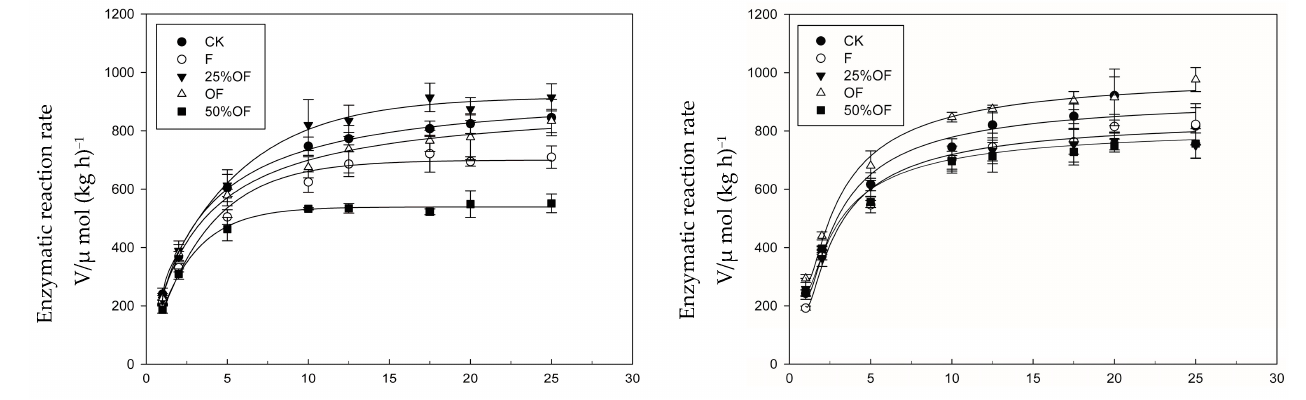
Figure 1. Curve of enzymatic reaction rate of β –glucosidase versus substrate concentration on jointing stage ( a ) and booting stage ( b ) of spring wheat. Data represent mean ± SD (n = 3). CK indicates no fertilizer treatment. F indicates single fertilizer treatment. 25% OF indicates 25% organic fertilizer plus 75% chemical fertilizer treatment. OF indicates organic fertilizer treatment. 50% OF indicates 50% organic fertilizer plus 50% chemical fertilizer treatment.